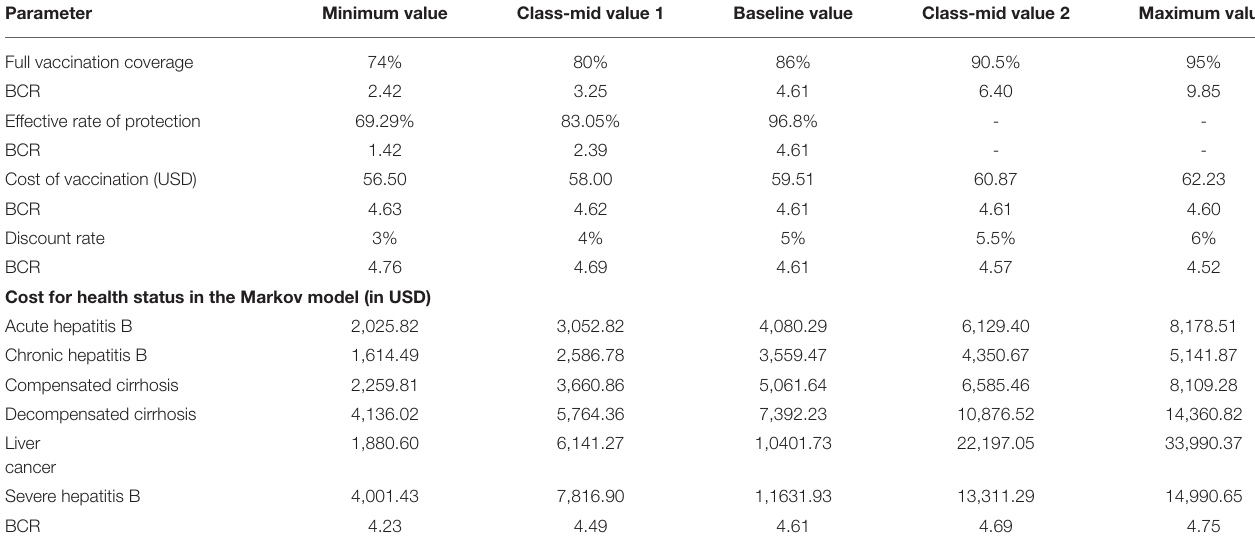
TABLE 7 | Parameter assignment for sensitivity analysis of the decision tree combined with the Markov model (in USD).